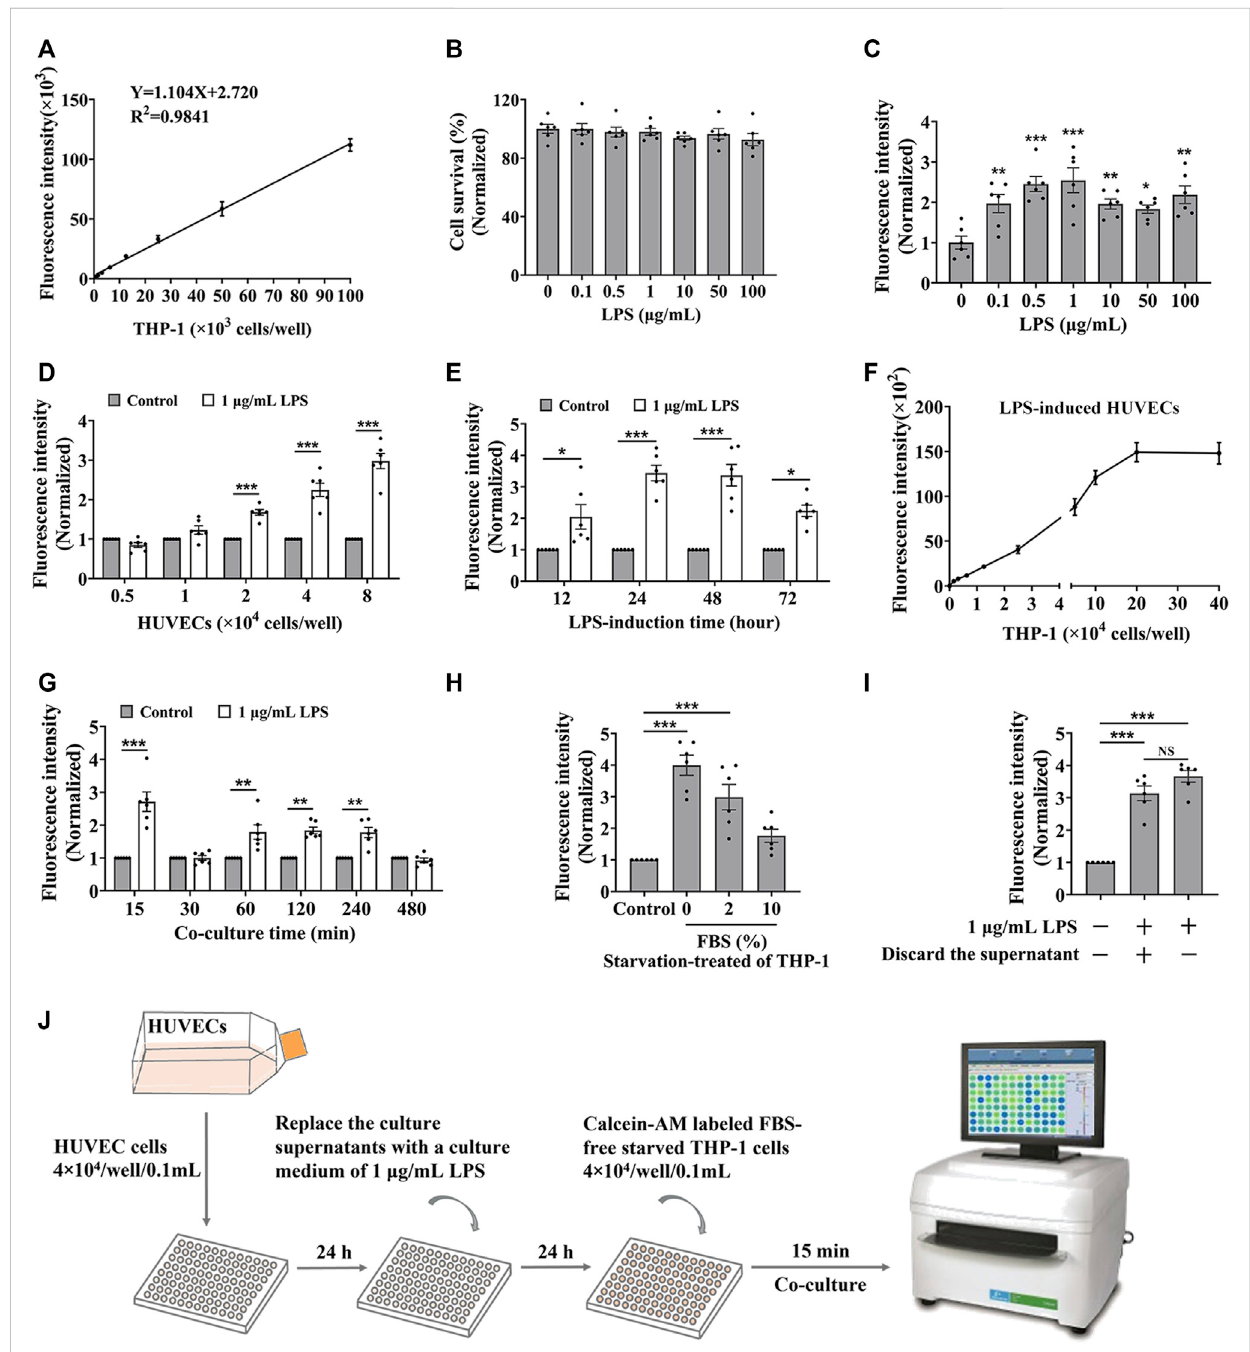
FIGURE 1 Theoptimizationofthecelladhesionconditionbetweenendothelialandmonocyticcells. (A) Thelinearrelationshipbetween fl uorescenceintensity and the amount of calcein-AM labelled THP-1 cells. (B) The cytotoxicity of LPS to HUVEC cells for 24 h. (C – E) HUVEC cells (4 × 10 4 cells/well) were treatedbyLPSfor24 h (C) ,ordifferentdensitiesofHUVECcellsweretreatedby1 μ g/mLLPSfor24 h (D) ,orHUVECcells(4×10 4 cells/well)weretreated by 1 μ g/mL LPS for different time (E) , and then co-cultured with labeled THP-1 cells (4 × 10 4 cells/well) for 45 min; or (F – H) HUVEC cells (4 × 10 4 cells/well) were treated by 1 μ g/mL LPS for 24 h, and then co-cultured with different amounts of labeled THP-1 cells for 45 min (F) or co-cultured with labeled THP-1 cells (4 × 10 4 cells/well) for different time (G) , or co-cultured with labeled THP-1 cells (4 × 10 4 cells/well) starved with media containing differentconcentrationsofFBSfor 15 min (H) ,thenthe fl uorescenceintensityweredetected. (I) The fl uorescenceintensity fromthecelladhesionmodel when the culture supernatants from LPS induced-HUVEC cells were discarded before HUVEC cells (4 × 10 4 cells/well) co-cultured with labeled THP-1 cells (4 × 10 4 cells/well) for 15 min. (J) The technological diagram of the cell adhesion model between HUVEC and THP-1 cells. Data were presented as mean ± SEM over three experiments. NS: no signi fi cance, * p < 0.05, ** p < 0.01, *** p < 0.001 vs.